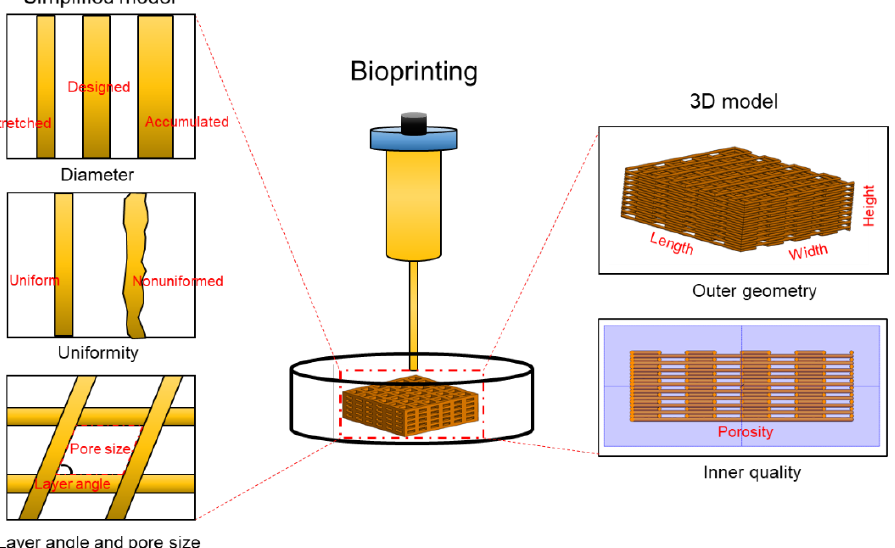
Figure 3. Geometrical parameters involved in the 3D bioprinting fidelity assessment.